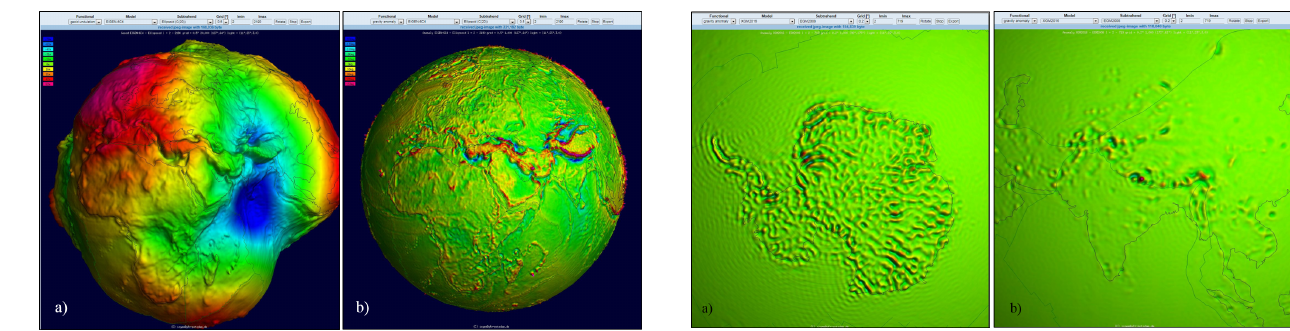
Figure 13. Examples of the visualization service for (a) geoid un- dulation and (b) gravity anomaly computed from a high-resolution combined static gravity field model.